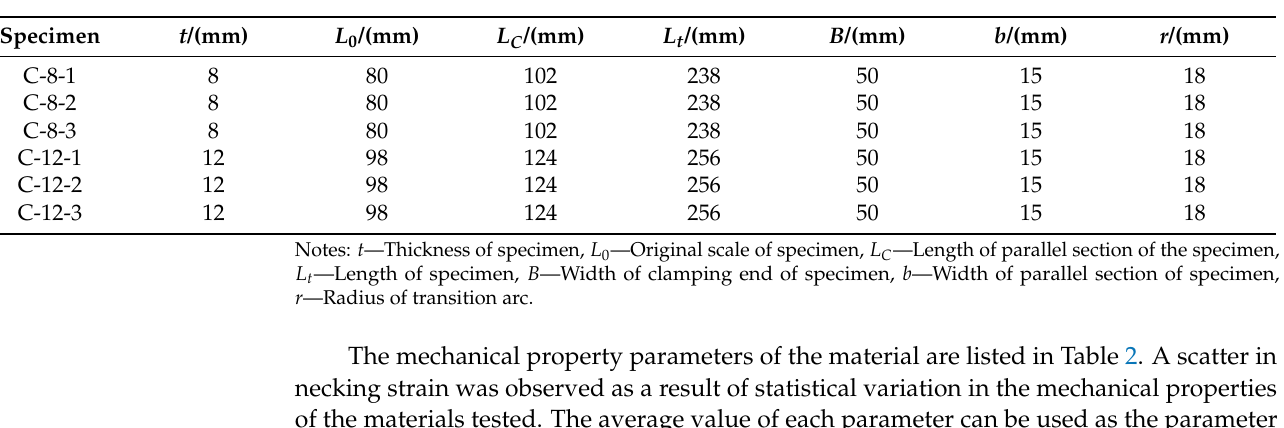
Figure 2. Tensile specimen. Table 1. Specimen geometry size.